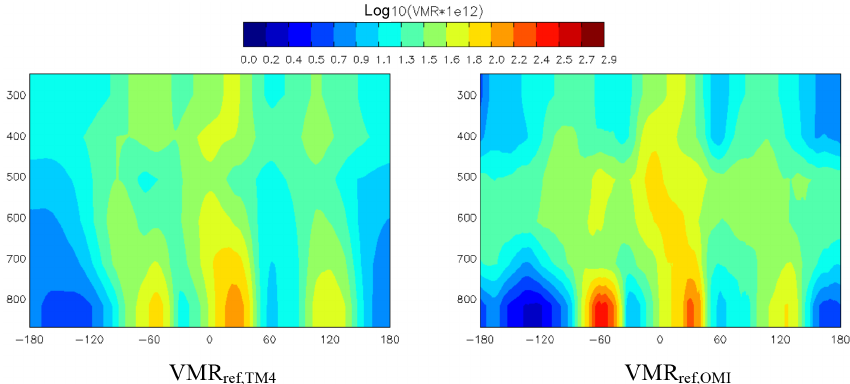
Figure 11. Longitudinal cross section of annual mean tropospheric NO 2 VMR in logarithmic scale from TM4 (left) and OMI (right) with CRF > 50% over the tropics (10 ◦ N–20 ◦